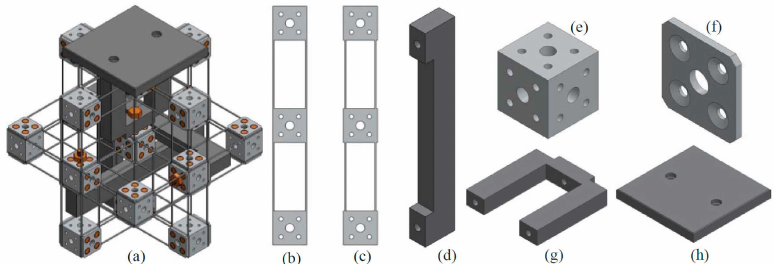
Figure 13. Practical design-I and its assembling accessories: ( a ) practical design-I, ( b ) compliant beam component with larger spanning size, ( c ) compliant beam component with smaller spanning size,